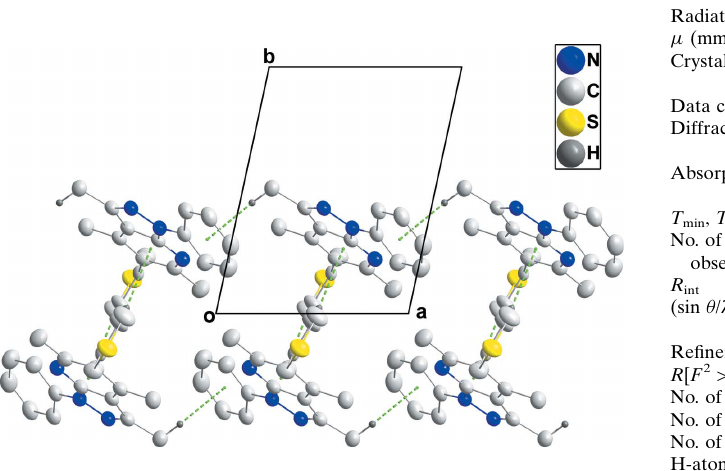
Figure 1 The title molecule with the labelling scheme and 50% probability ellipsoids. The intramolecular C—H (cid:2)(cid:2)(cid:2) N hydrogen bond is shown as a dashed line.